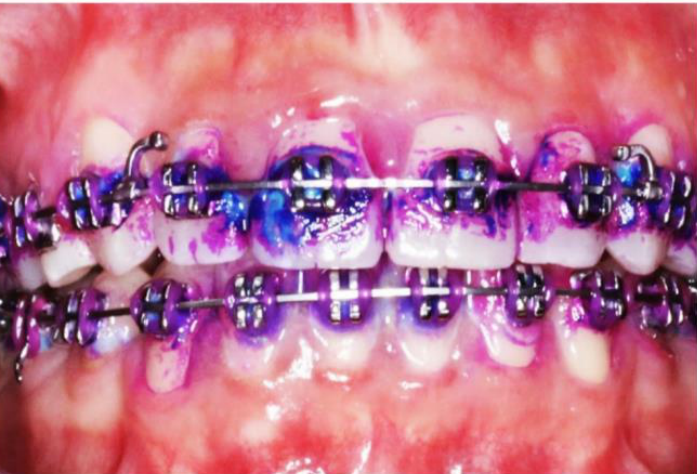
Figure 1. Common dental biofilm-related issues in an orthodontic patient. Cariogenic dental biofilm that is stained light blue is seen on 11 and 12. Mature dental biofilm is stained dark purple-blue, and immature dental biofilm is stained pink.